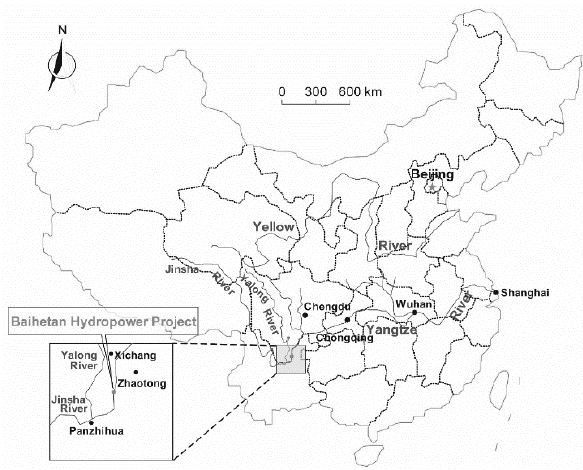
Figure 1. Project location map [26] (Copyright © 2017, Springer Nature).